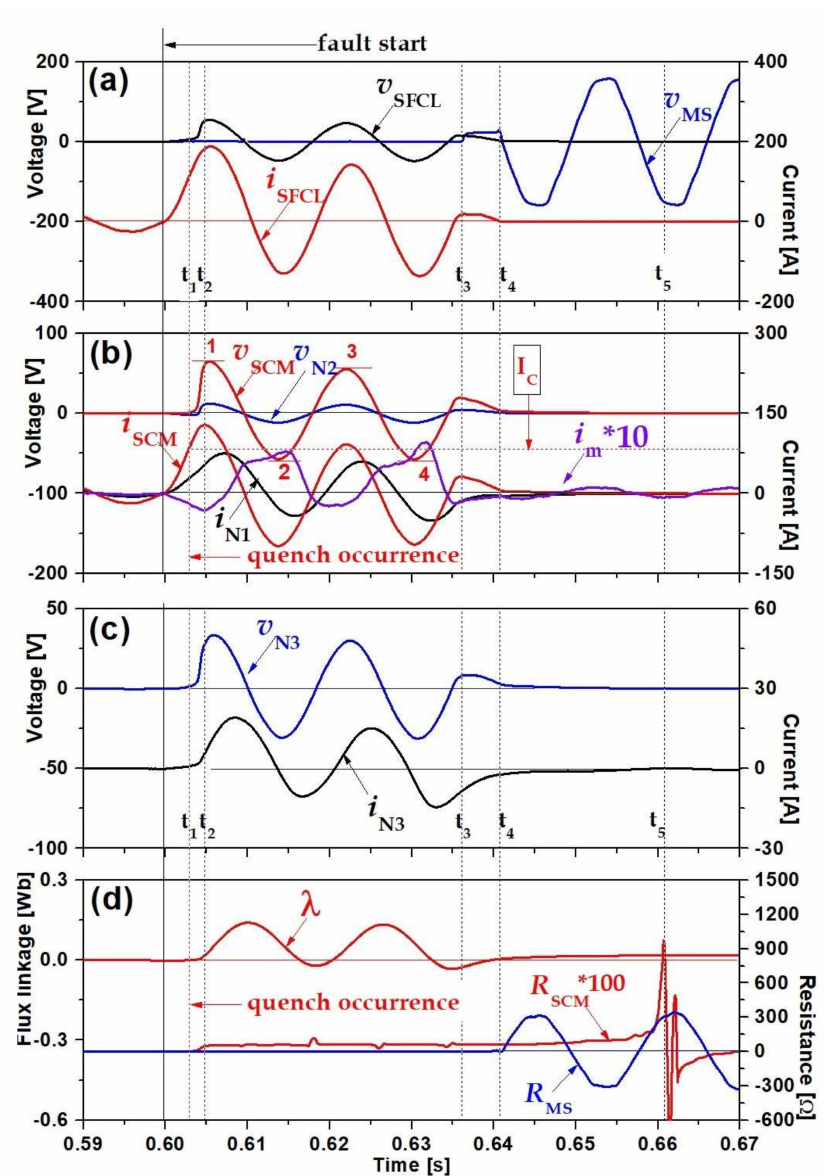
Figure 7. Fault current limiting and breaking operational waveforms of the SFCLB using flux coupling with a tap changer in the case of a parallel connection. ( a ) Voltages of MS and SFCL ( v MS , v SFCL ), current of MS ( i MS = i SFCL ). ( b ) Voltages of coil N 2 and SCM ( v N2 , v SCM ), currents of coil N 1 , SCM and magnetizing branch ( i N1 , i SCM , i m ). ( c ) Voltage of coil N 3 ( v N3 ) and current of coil N 3 ( i N3 ). ( d ) Flux linkage ( λ ) and resistance of SCM and MS ( R SCM , R MS